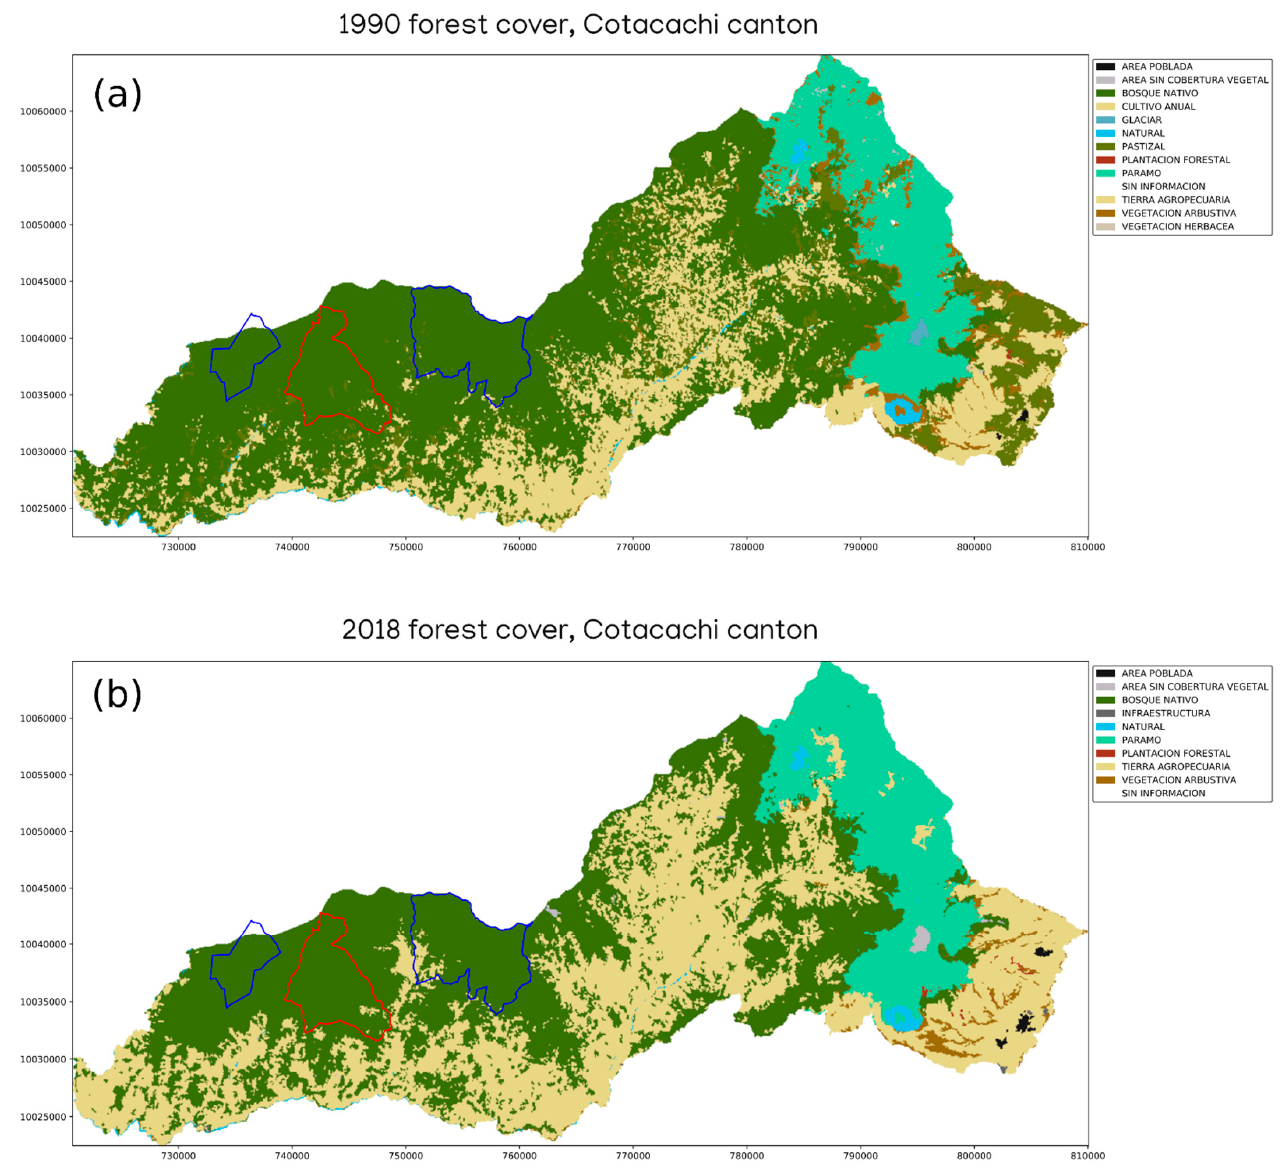
Figure 10. Land-cover changes in the Cotacachi canton. Reserva Los Cedros is outlined in red, and two other nearby protected forests are outlined in blue (B.P. Cebu to the west and B.P. Chontal to the east). Forest cover is shown in dark green, and agricultural land in beige. Geographic coordinate system is PSAD56 / UTM zone 17S, in meters. ( a ) 1990; ( b ) 2018.